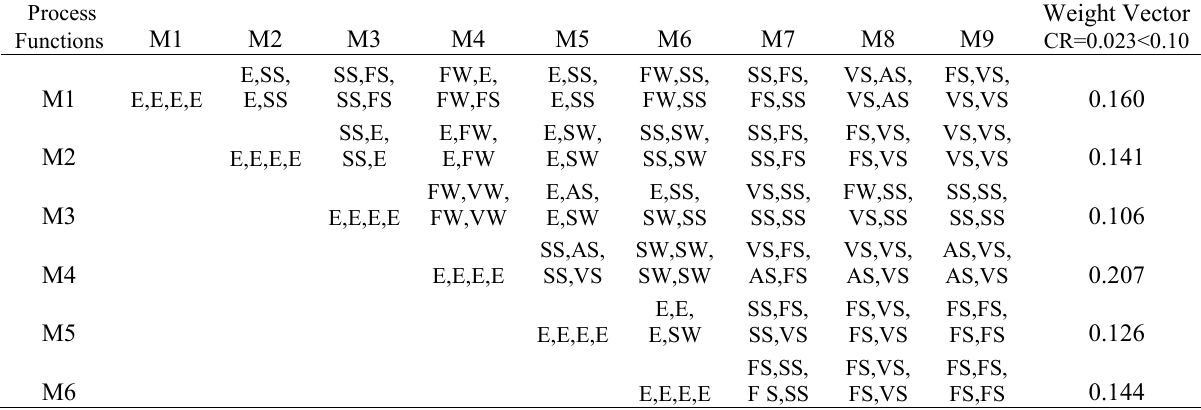
Table 3. Pair-wise evaluations of experts in linguistic variables for the process functions